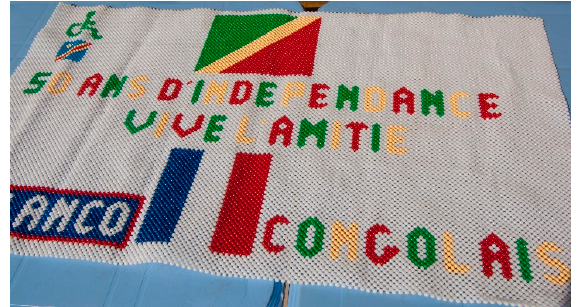
Figure 8. Nappe (cloth).